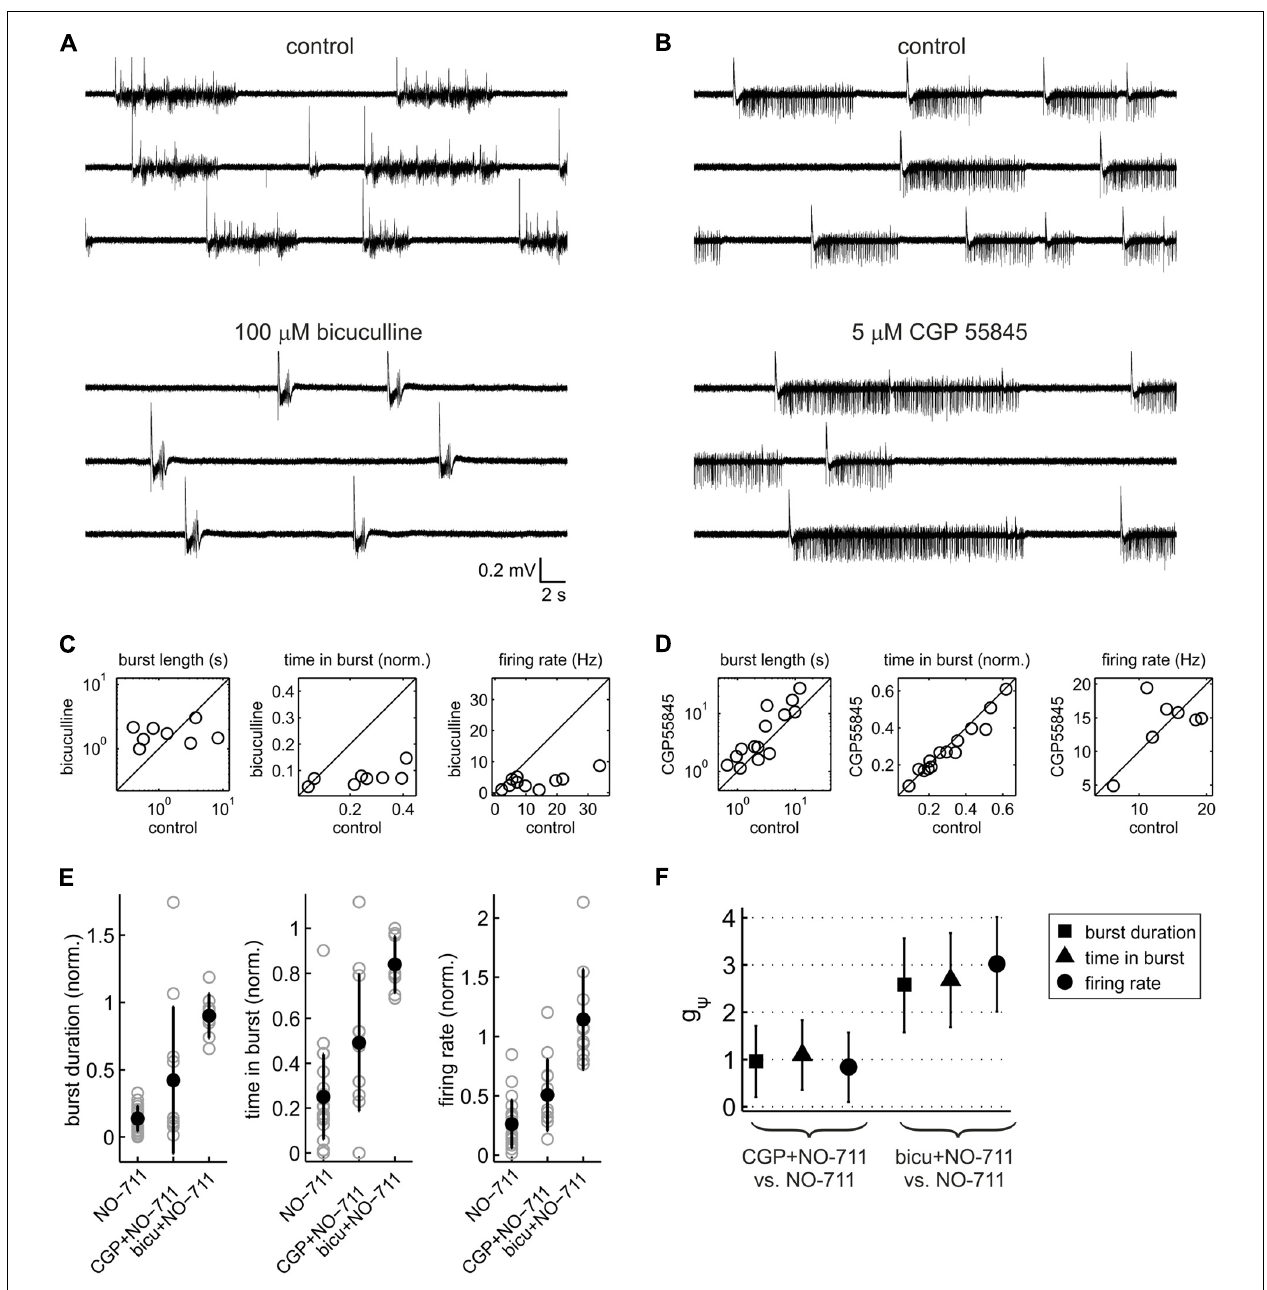
FIGURE 4 | Contribution of GABA A and GABA B receptors to activity patterns and to the depressant effects of NO-711. (A) Exemplary extracellular recording of a culture exposed to the GABA A receptor antagonist bicuculline (broadband signal). Note the drug-induced stereotyped appearance of the network bursts. (B) Exemplary extracellular recording with the GABA B receptor blocker CGP55845 (5 μ M). (C) Effect of bicuculline (100 μ M) on median burst duration (left), proportion of time spent in bursts (center), and average firing rate (right). Bicuculline appeared to “clamp” burst duration at 1.8 ± 0.7 s (mean ± sd), on average causing a prolongation with wide margins of uncertainty ( g 1 (1) = 0.52 [ − 0.24 1.25], p = 0.18, n = 8); it strongly reduced both the proportion of time spent in bursts ( g 1 (1) = − 1.58 [ − 2.62 − 0.49], p = 0.003, n = 8) and average firing rates ( g 1 (1) = − 2.60 [ − 3.90 − 1.25], p = 1.8 * 10 − 5 , n = 10). (D) Effect of CGP55845 (5 or 10 μ M) on the same parameters as shown in (C) . CGP55845 increased burst duration